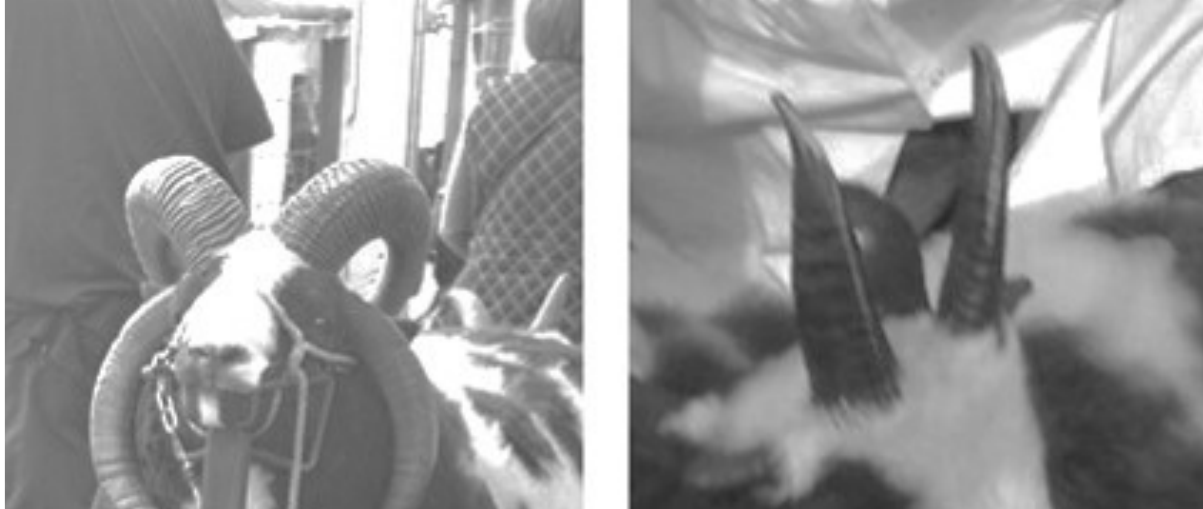
Figure 2 : Example of the gender difference relative to horn size in the male (left) and female (right) within the Jacob